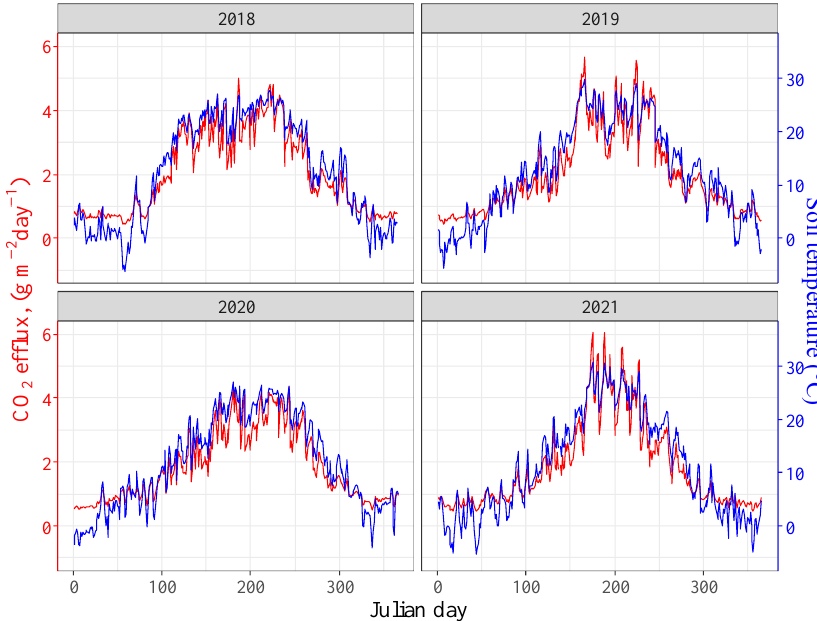
Figure 7. Daily CO 2 efflux (g m − 2 d − 1 ) of undisturbed bare soil, calculated with the exponential model